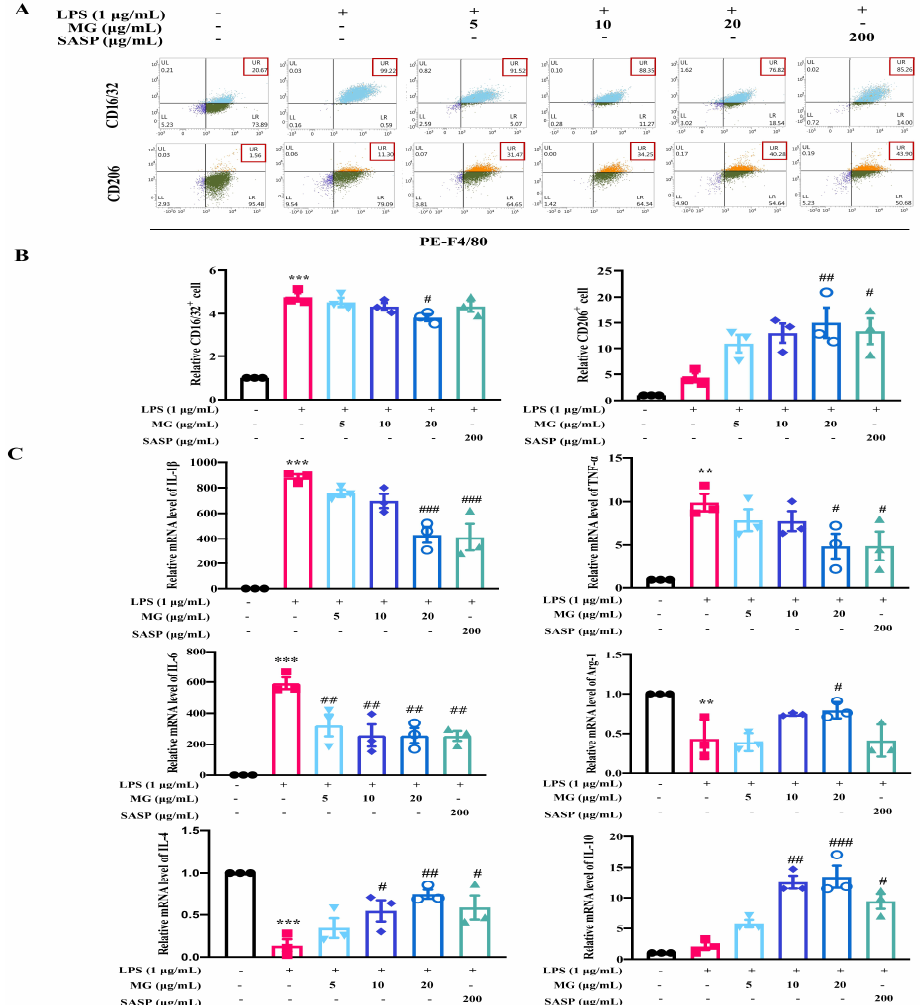
Figure 2. Effect of MG on RAW264.7 cell polarization. ( A , B ) Flow cytometry analysis of MG on RAW264.7 cell polarization in vitro. ( C ) qPCR analysis of MG effect on polarization-related mRNA levels in RAW264.7 cells. Data were presented as the means ± SEMs of three independent experiments. ** p < 0.01, and *** p < 0.001 vs. the normal group; # p < 0.05, ## p < 0.01, and ### p < 0.001 vs. the group treated with only LPS.